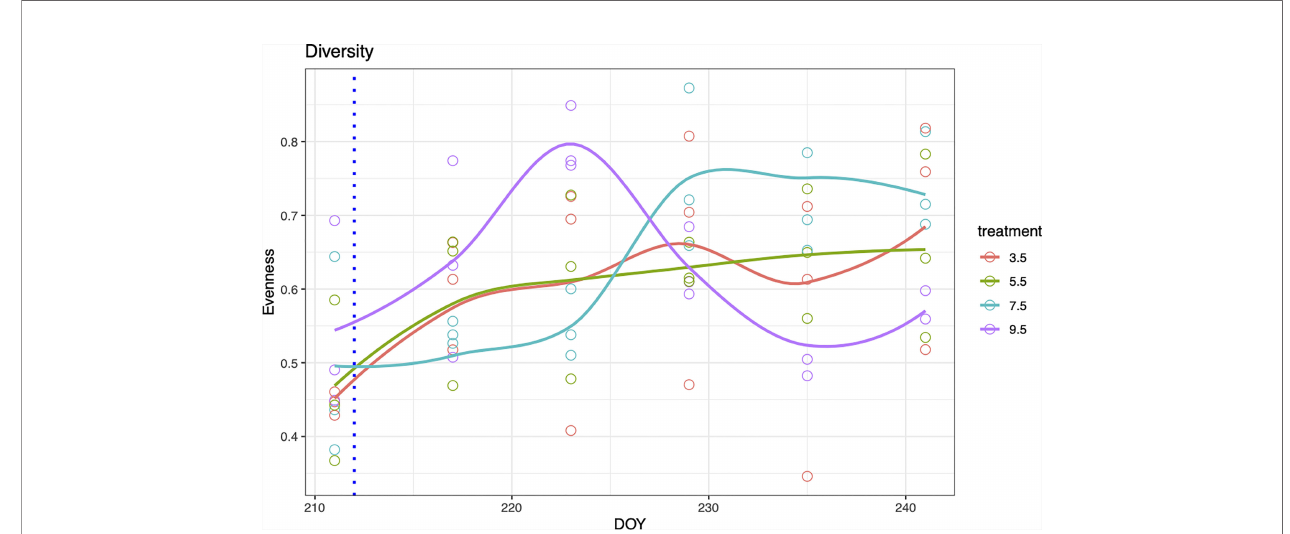
FIGURE 2 | Zooplankton community evenness for each treatment over time. The dashed blue line at DOY 211 indicates salt